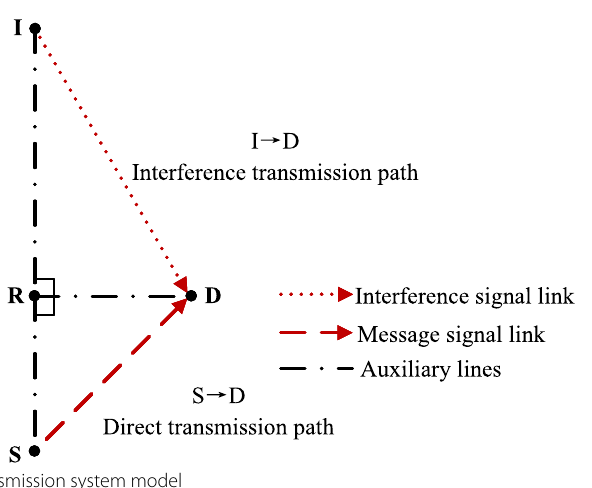
Fig. 5 Direct transmission system model